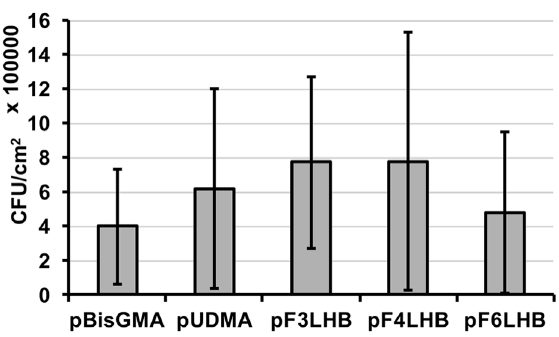
Figure 6. Adhered S. mutans after 24 h of incubation at 37 °C in 5% CO 2 under static conditions for select fluorinated polymers and controls ( n = 14, ± SD).